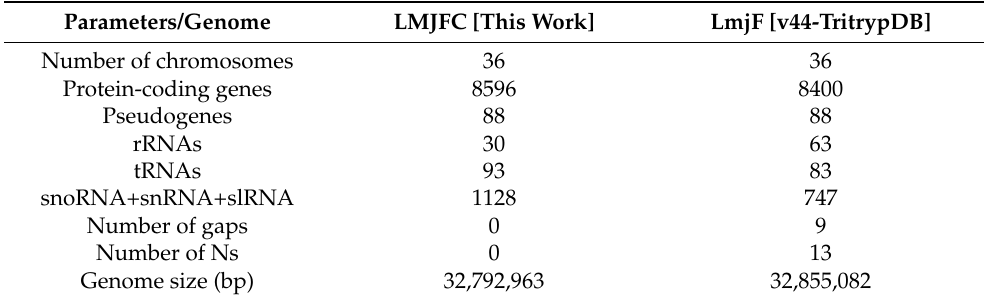
Table 1. Parameters in the new (LMJFC) and previous (LmjF) genome assemblies.